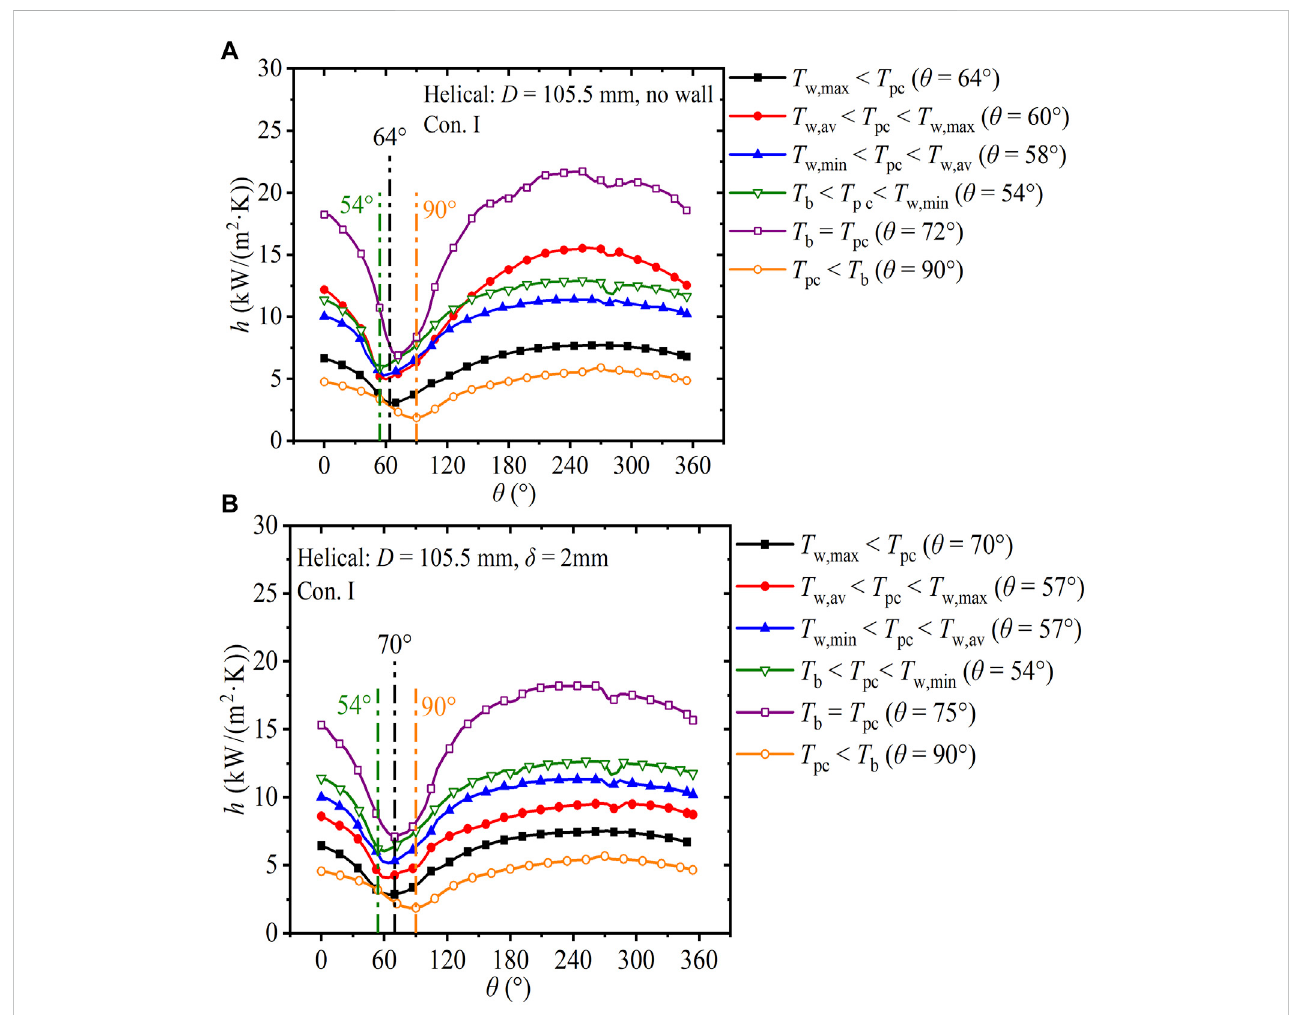
FIGURE 10 Development of circumferential heat transfer coef fi cients in the helical tube (Con. I: G in = 225